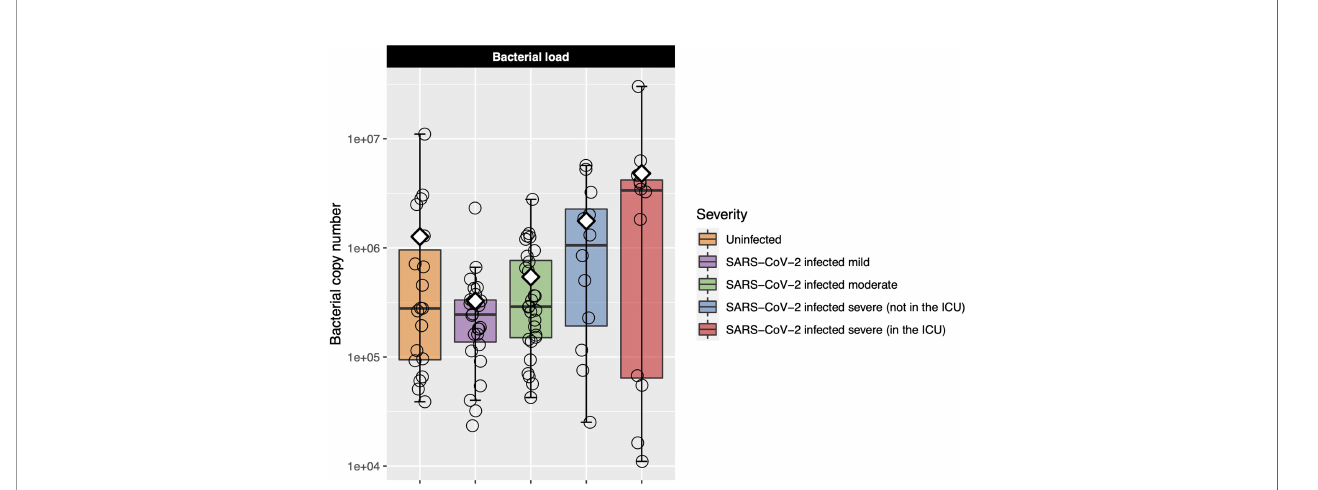
FIGURE 2 | Log-transformed bacterial load is shown for each of the COVID-19 severity groups. Each box represents the median and interquartile range, and the mean is shown by the white diamond. Individual points are shown as open circles. Bacterial load of the uninfected control participants was similar to that of those with mild-to-moderate COVID-19. Among those with COVID-19, there was a trend toward increasing bacterial load as disease severity increased.